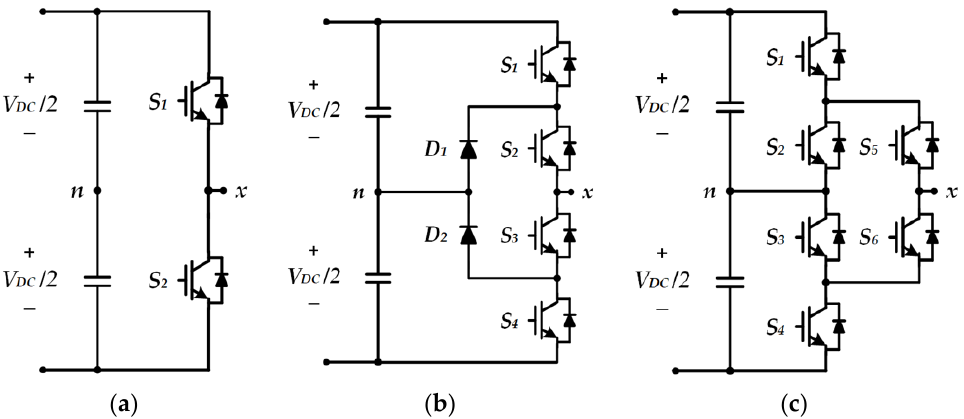
Figure 2. Three types of voltage source inverters: ( a ) two-level (2L)-inverter; ( b ) standard 3L-NPC (three-level neutral-point clamped) inverter; ( c ) active NPC inverter.